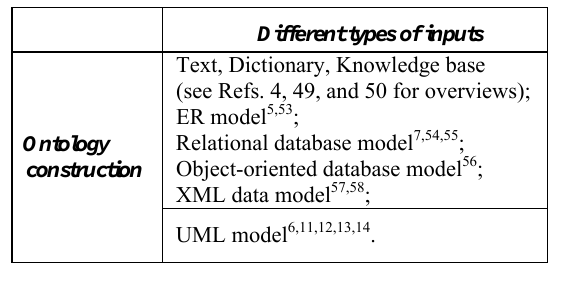
Table 4. Survey of classical ontology construction